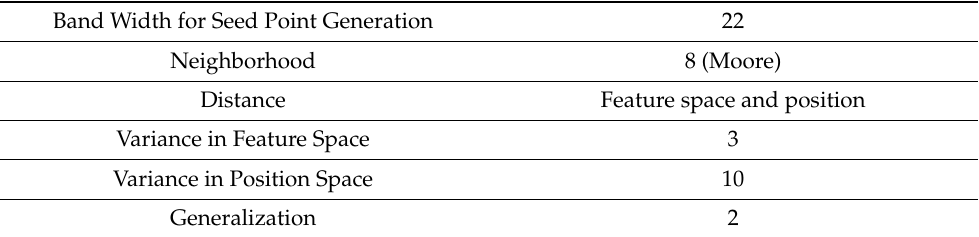
Table 2. Object Based Image Segmentation parameters settings.